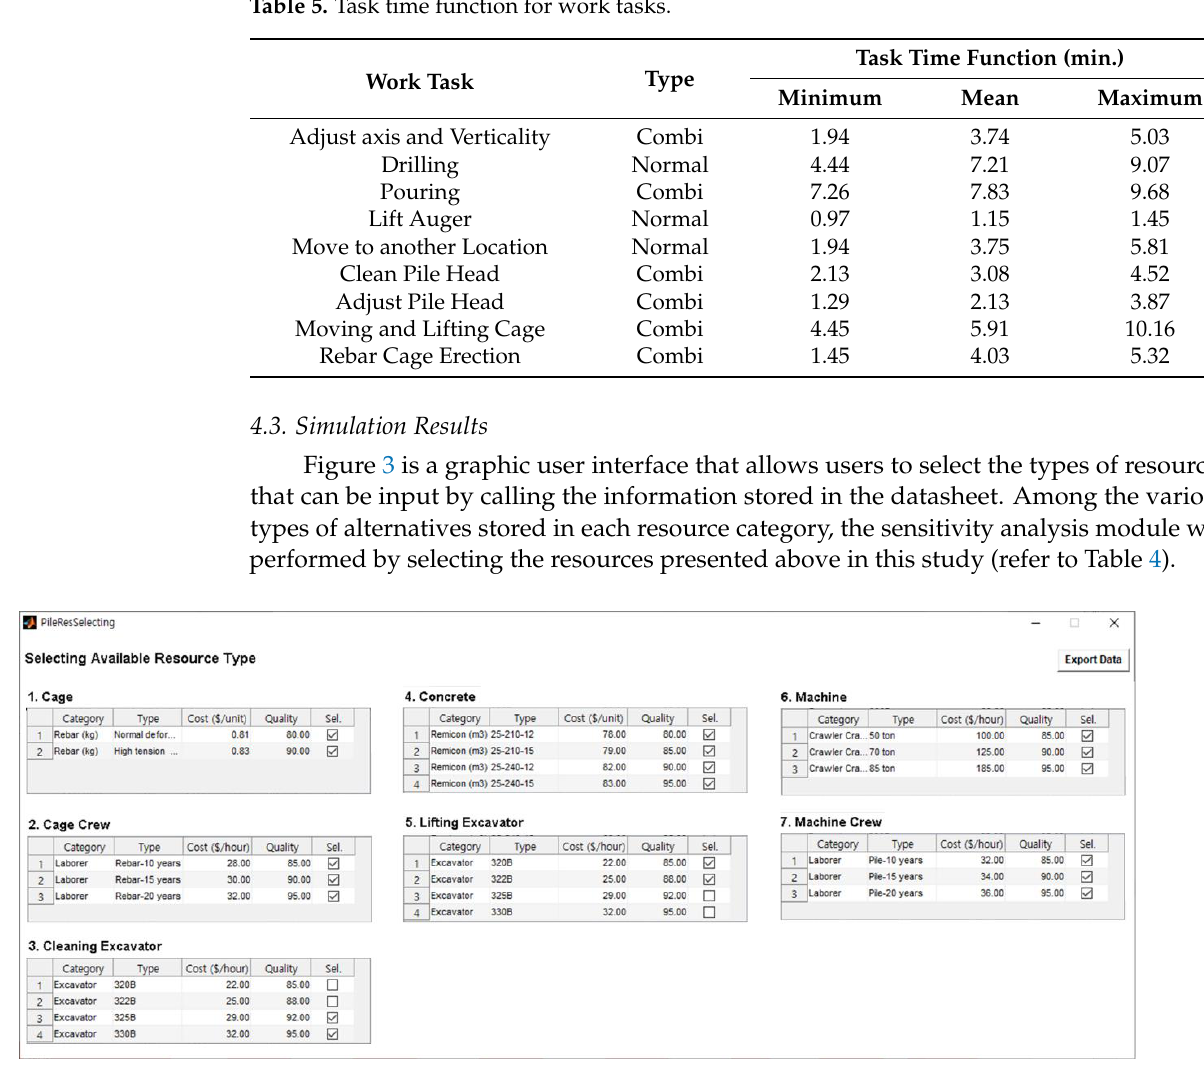
Figure 3. Graphic user interface for choosing available types of resources.